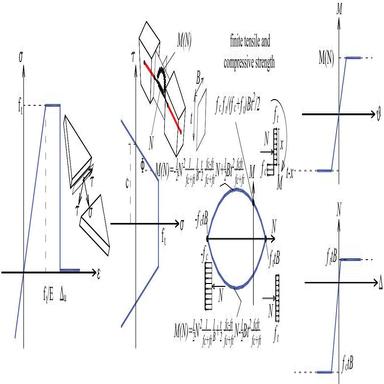
Left: Uniaxial stress-strain relationship and frictional behavior assumed for triangle/triangle interfaces (vault). Right: beam/beam interfaces (perimeter walls) with bending moment and axial load relationships.